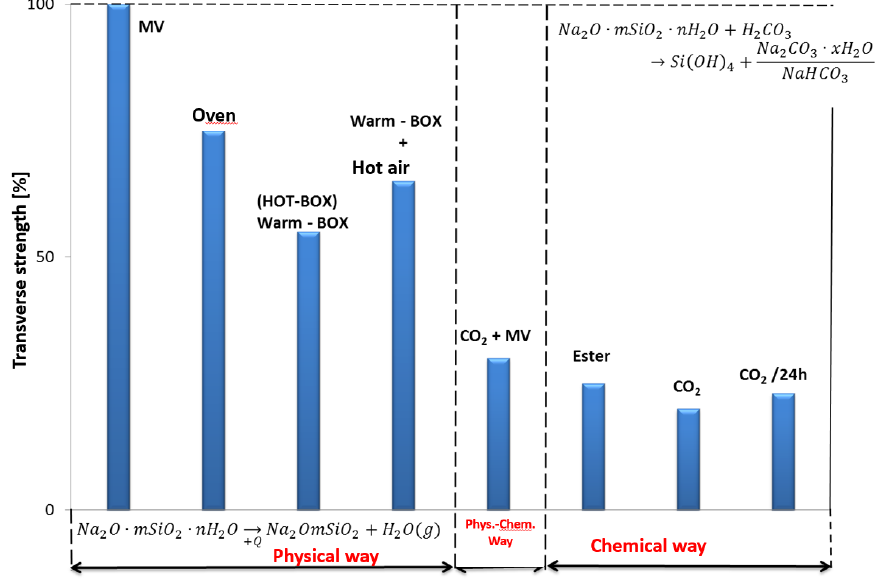
Figure 1. Transverse strength of molding mixtures using alkaline silicates binders cured by different methods [7].